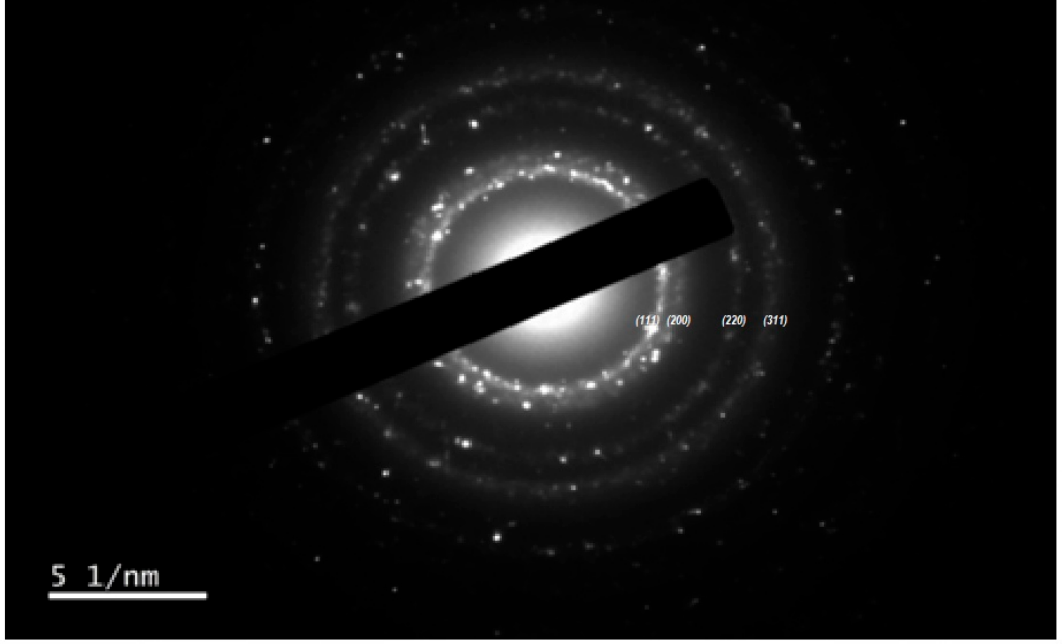
Figure 8. SAED pattern of C-Ag NPs from C2 (0.25 g) samples.